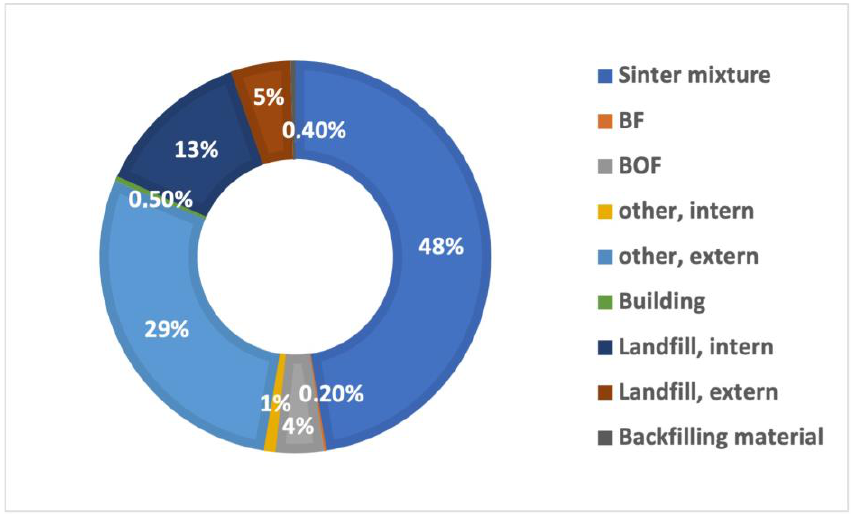
Figure 6. Industrial utilization of dust and sludge in 2018.